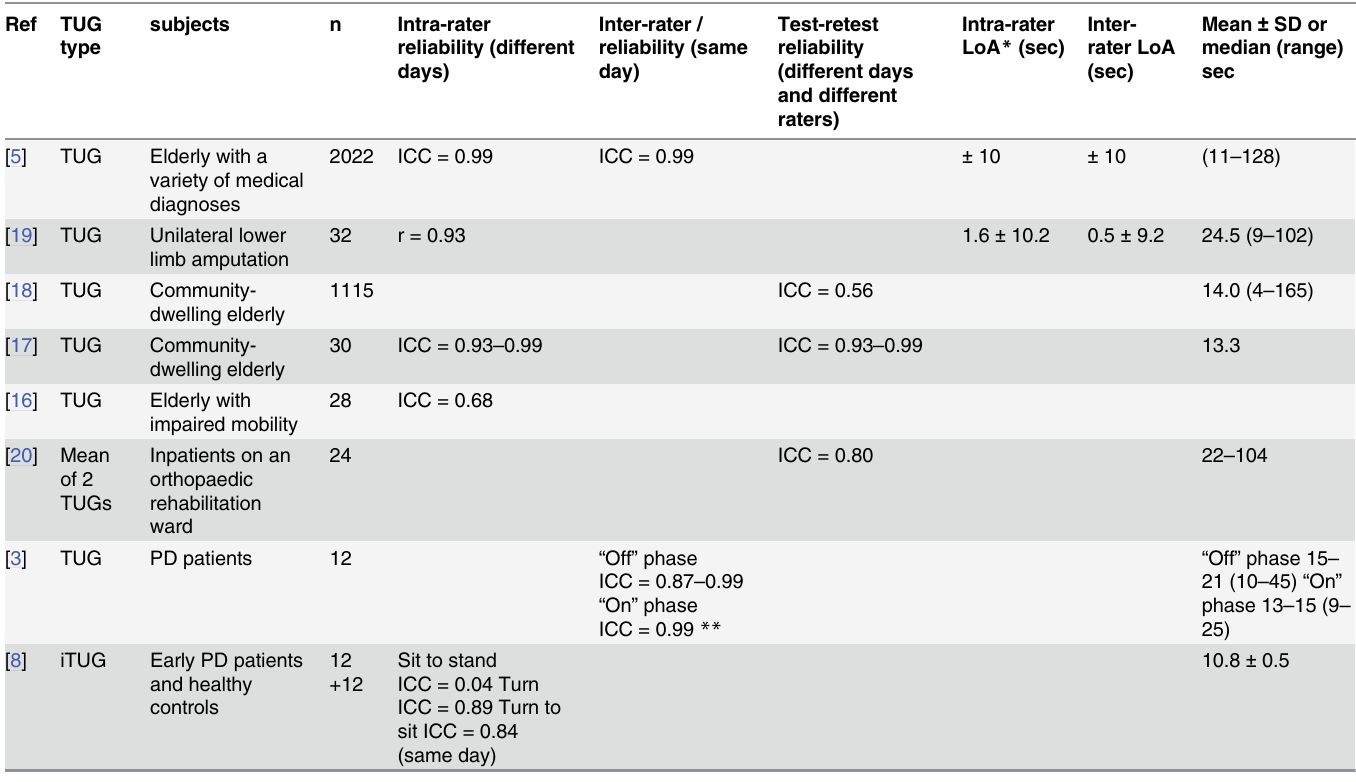
Table 5. Results from earlier reliability